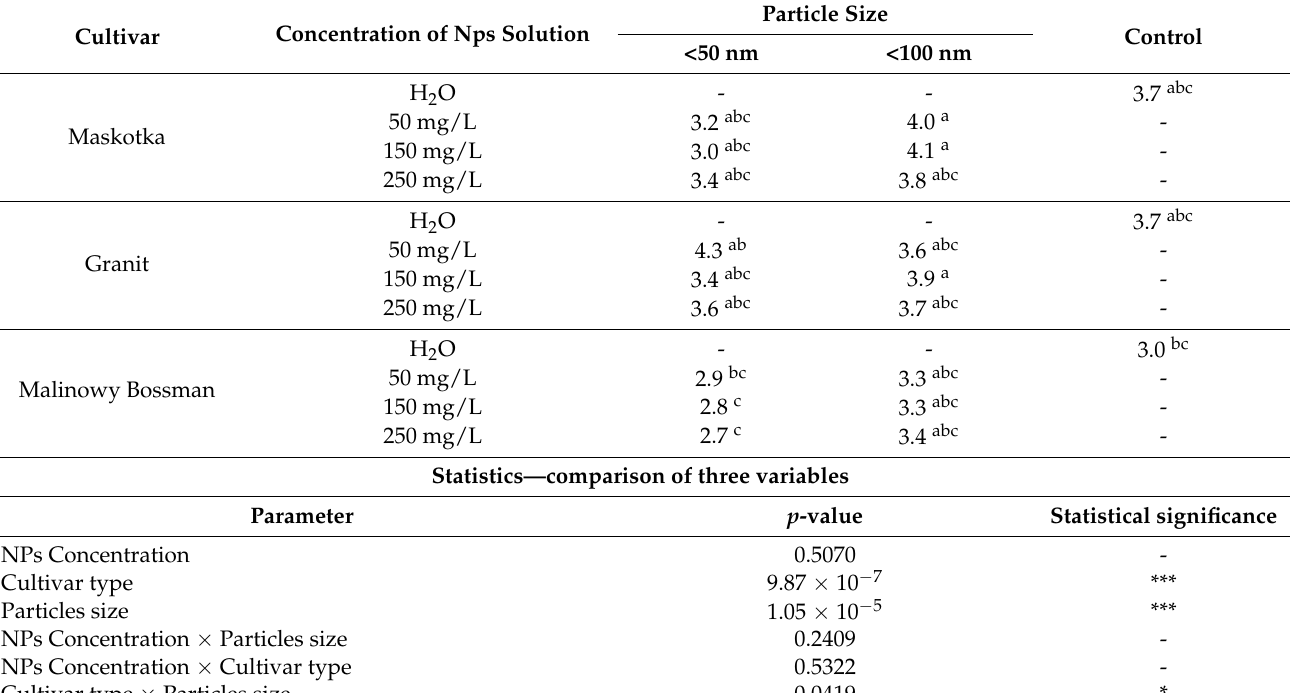
Table A1. The results of mean germination time (MGT) parameter obtained after treatment and statistic calculations. For this growth parameter, three variables were taken under consideration (NPs suspension, cultivar type, and the size of used NPs). In statistical part of the table, the statistical significance is expressed as “-” which means that p -value was higher than 0.05 and certain parameters had no significant influence on the results; “*” means that p -value is lower than 0.05, and “***”